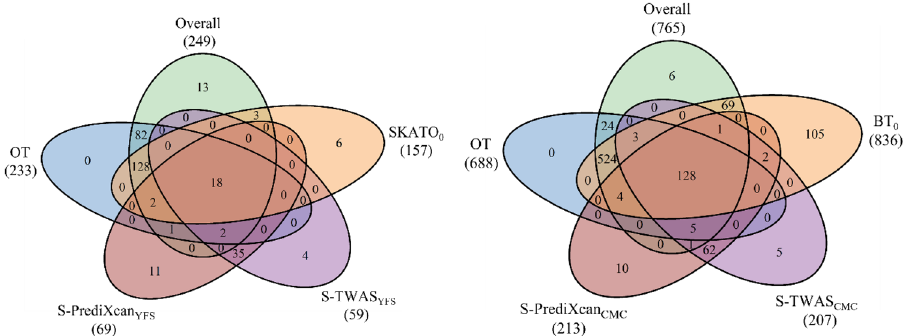
Figure 4. Venn diagram of the number of genes identified by Overall, OT, SKATO 0 , S-PrediXcan YFS , and S-TWAS YFS for HDL1 data (left) and Overall, OT, BT 0 , S-PrediXcan CMC , and S-TWAS CMC for HDL2 data (right). The number below each method indicates the total number of significant genes identified by the corresponding